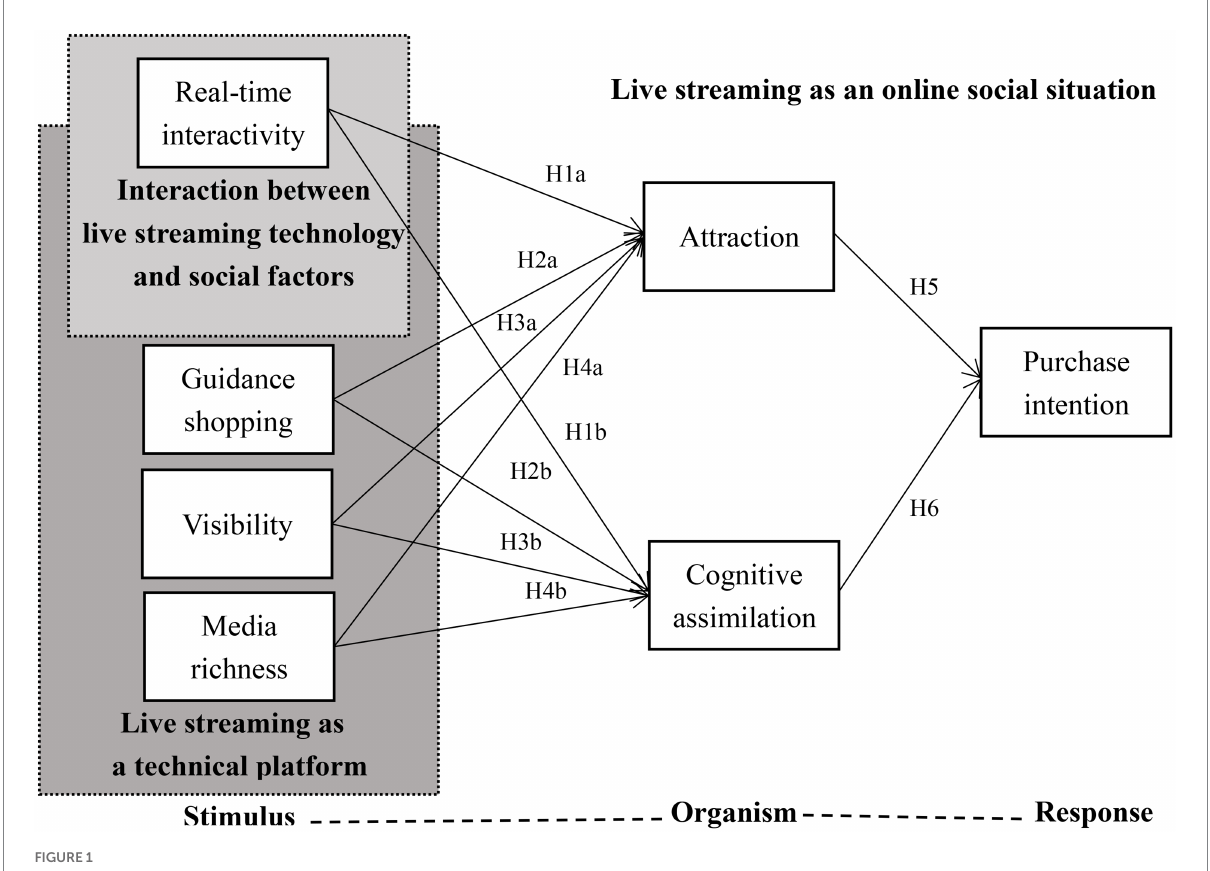
FIGURE 1 Research